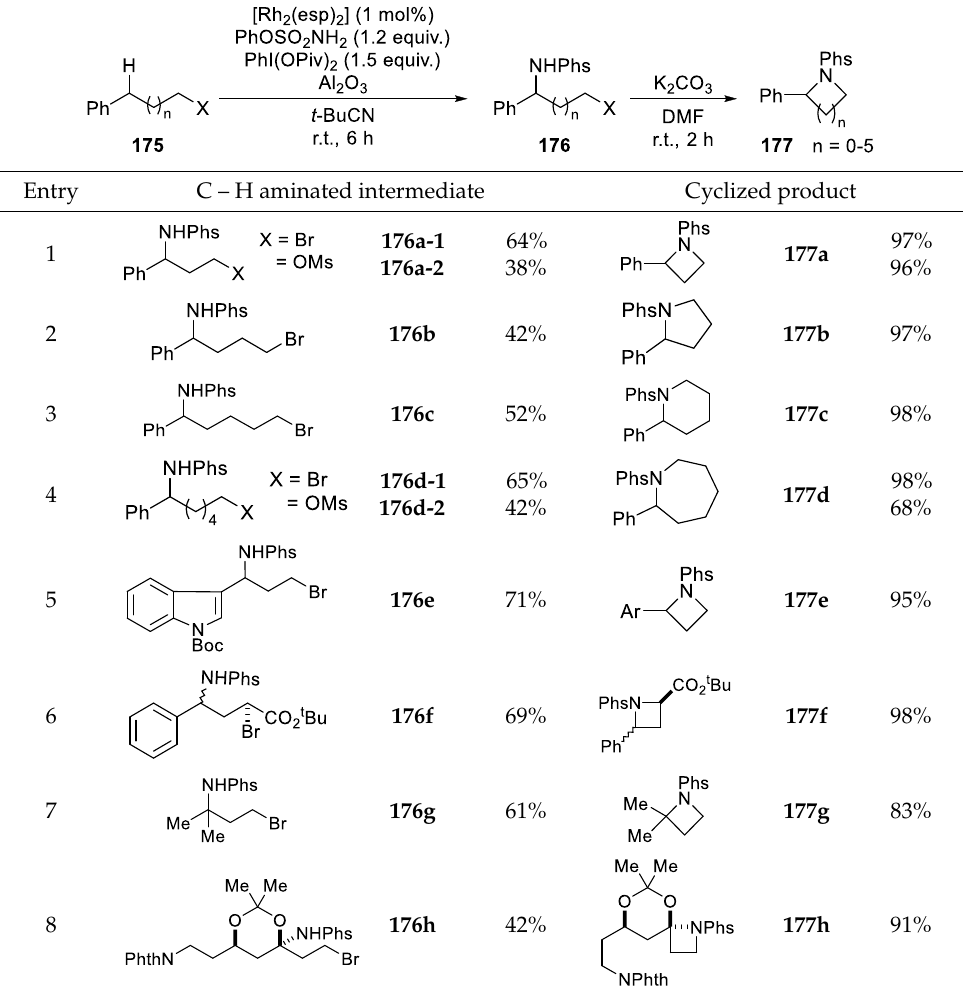
Table 3. Synthesis of azacycles via C–H amination and intramolecular cyclization.